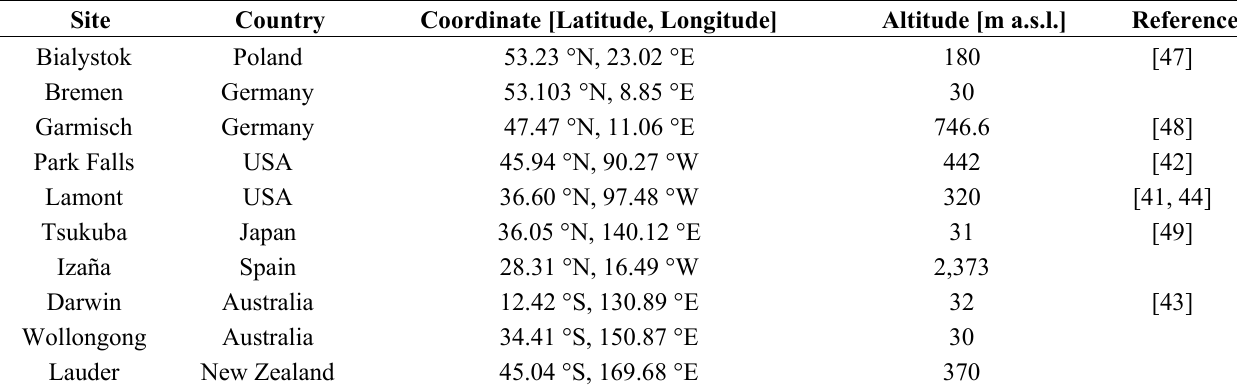
Table 2. TCCON sites used for satellite products